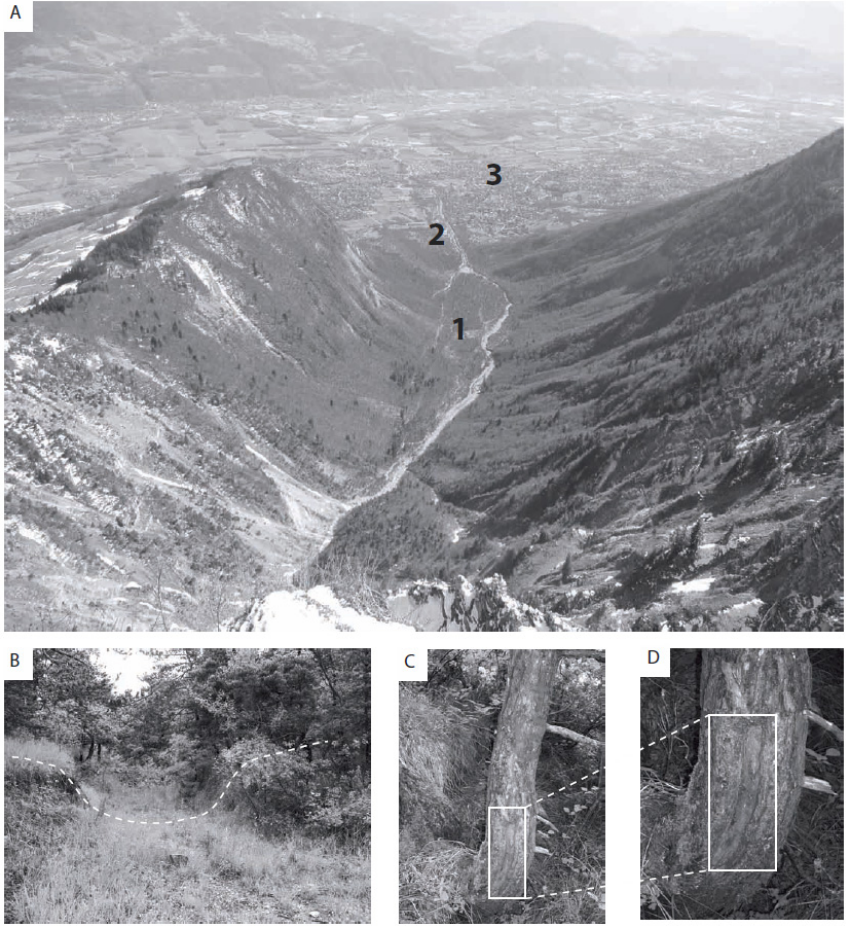
Fig. 1. (A) Overview of the Manival catchment as seen from the upper basin with (1) the study site, (2) debris-flow cone, and (3) the village of Saint-Ismier; (B) View of an abandoned channel with characteristic lateral levees covered with (C, D) trees affected by past debris-flow